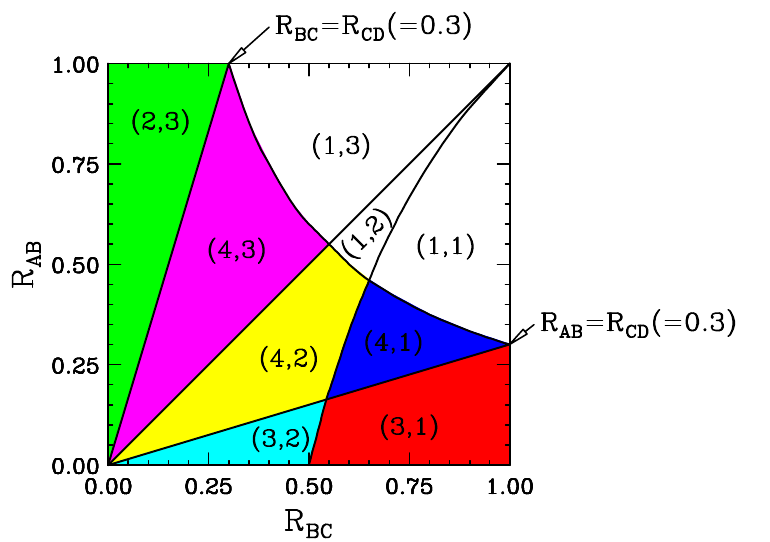
Figure 2 . A slice through the ( R BC ; R AB ) plane exhibits the nine de(cid:12)nition domains ( N jll ; N jl ) of the set of equations